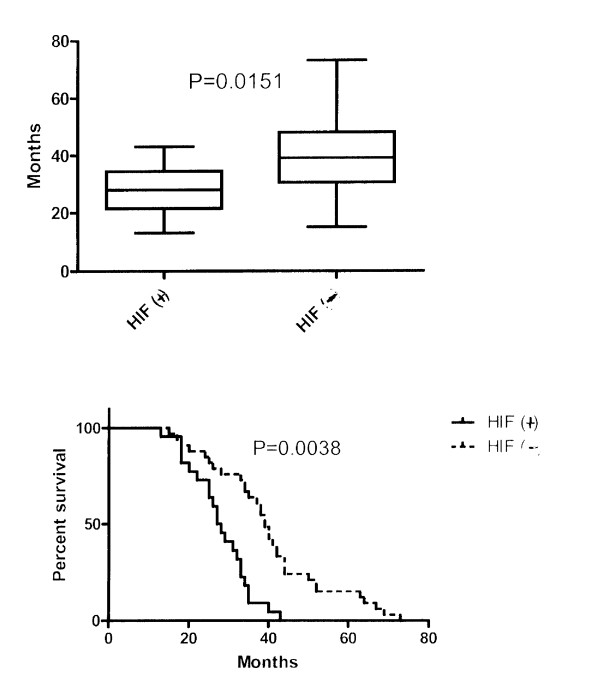
Survival analysis HIF(+) vs HIF (-).